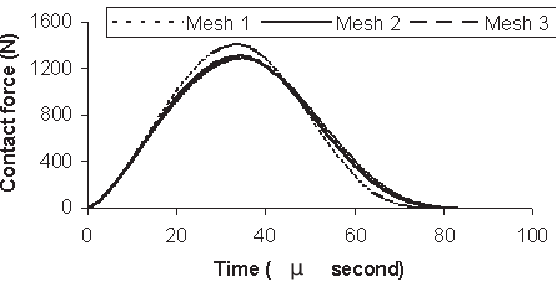
Fig. 3. Variation of adaptive contact force (point contact) on isotropic plate with respect to time.